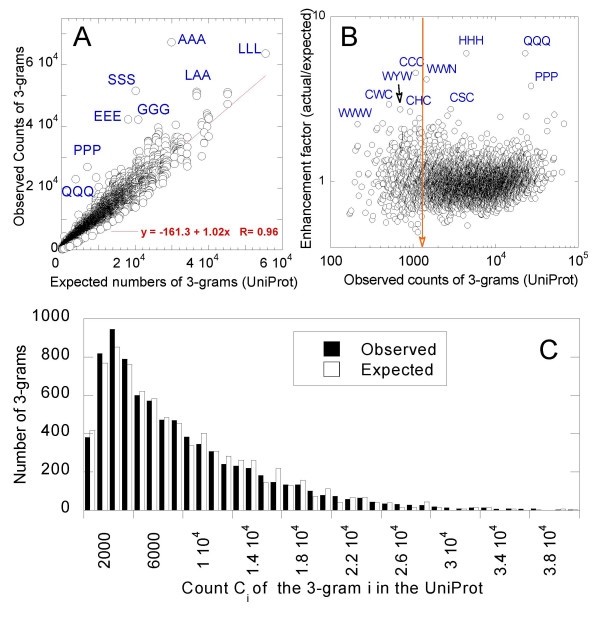
Observed vs expected counts of 3-grams. (A) Observed counts (Ci) are directly retrieved for all 203 types of 3-grams from the UniProt. Expected counts are based on the natural frequencies of individual amino acids (eq 3). Observed counts (Ci) usually match the expected ones (slope of best fitting line is 1.02), although particular 3-grams (labeled) are enhanced. The correlation coefficient between observed and expected counts is 0.96. The enrichment ai in particular 3-grams is shown in panel B. The observed counts are plotted in a log-log scale, to provide a clearer view of the subset of unique 3-grams (to the left of the arrow). (B) Comparison of observed histogram of 3-grams (Figure 1) and that expected from the independent frequencies of occurrences of amino acids in each triplet. The two histograms are significantly different (χ2, P < 0.001).